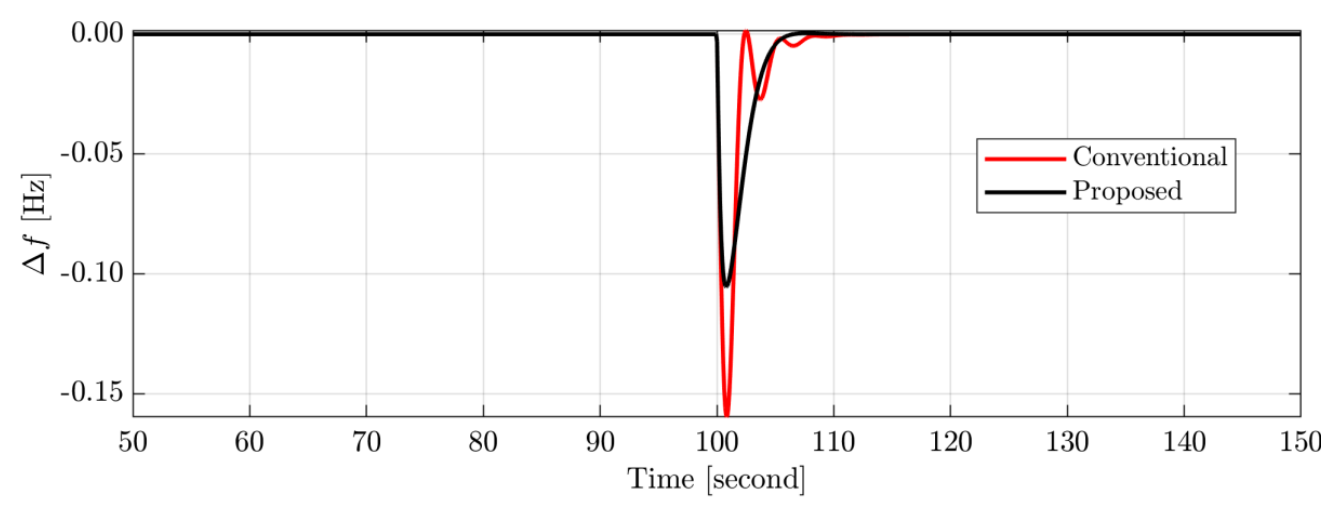
Figure 6. Sudden load change for the case 1.